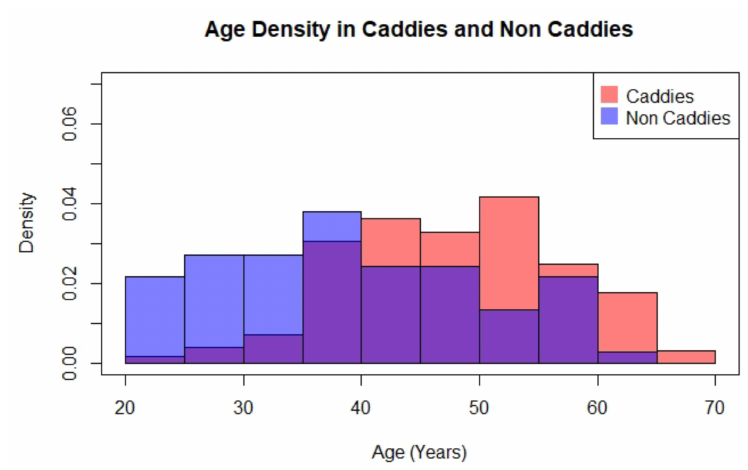
Figure 2. Age Density in Caddies and